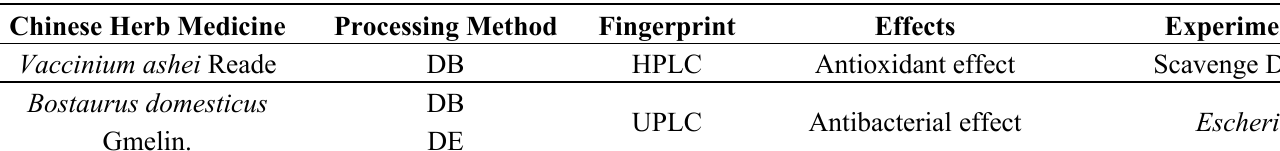
Table 1. Summary of single herb spectrum-effect